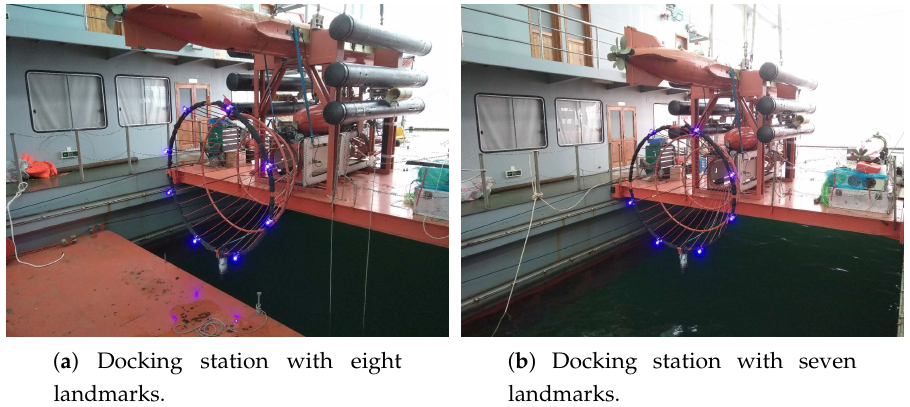
Figure 11. Docking stations with eight and seven